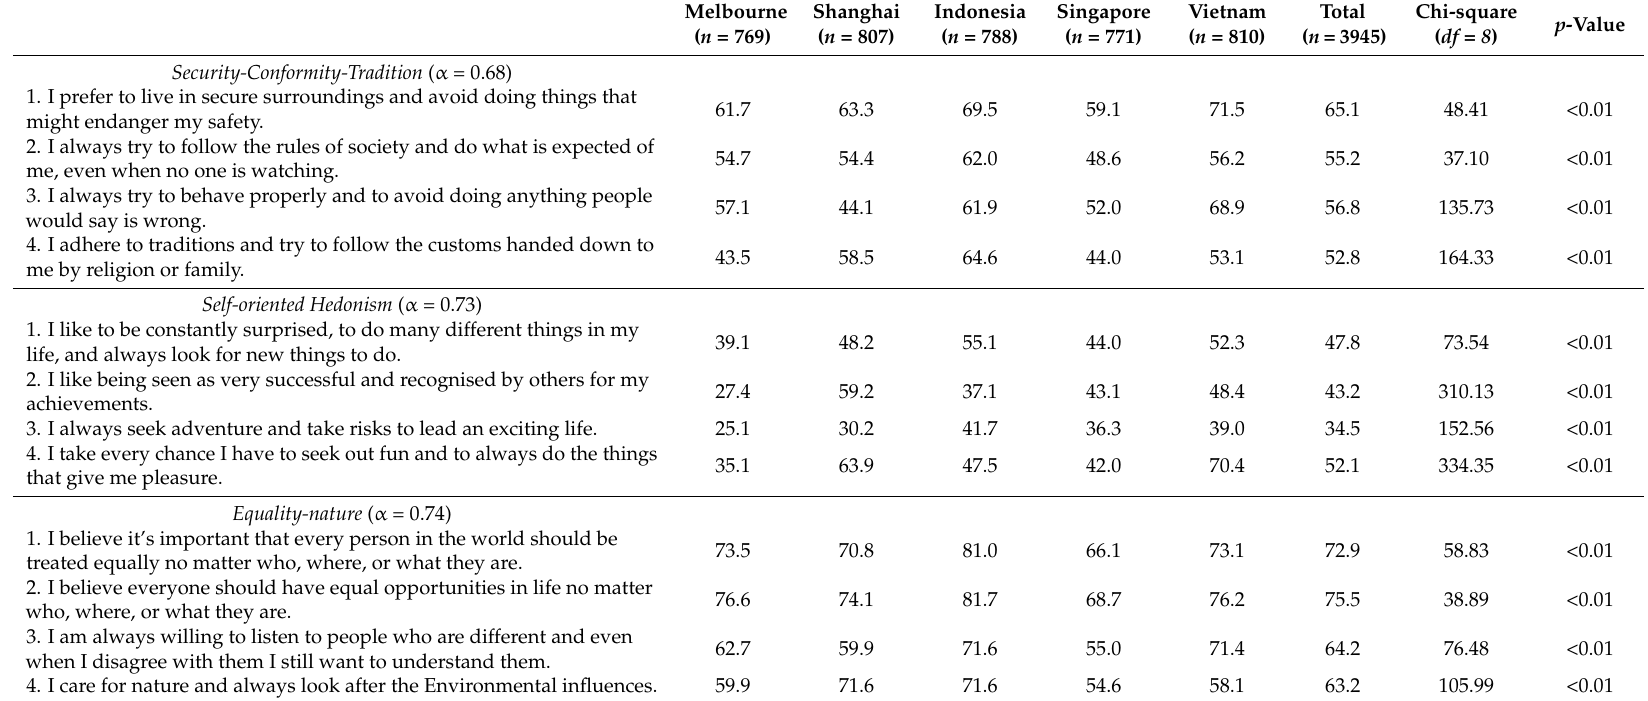
Table 5. Household food providers’ personal values (per cent like me, ratings 4 +